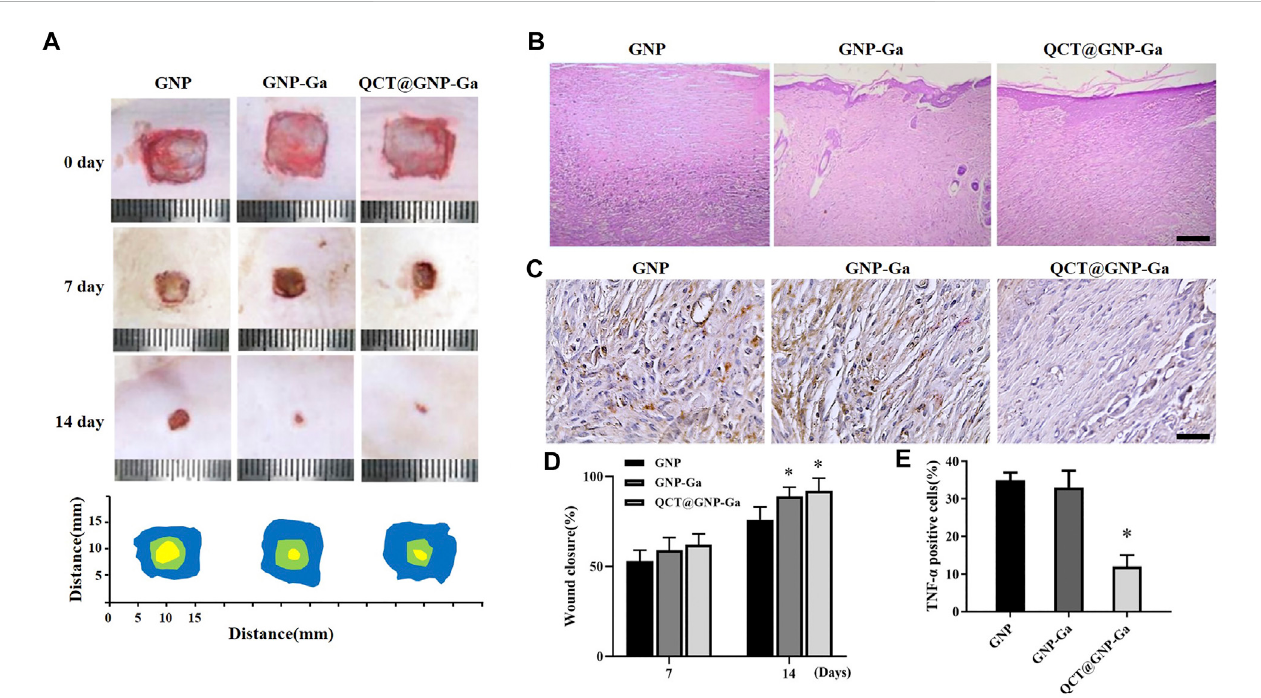
FIGURE 6 Invivo repaireffectofQCT@GNP-Gaonratskinwounds. (A) RepresentativeimagesofwoundhealingcoveredbyGNP,GNP-GaorQCT@GNP-Gafrom 0to14 daysand (D) quantitativeresults. (B) RepresentativeHEstainingimagesoftissuefromhealingwoundsofGNP,GNP-Ga,orQCT@GNP-Gagroup,Scale bar= 100 μ m. (C) Representative TNF- α immunohistochemical staining images and (E) quantitativeresultsof tissue fromhealing wounds